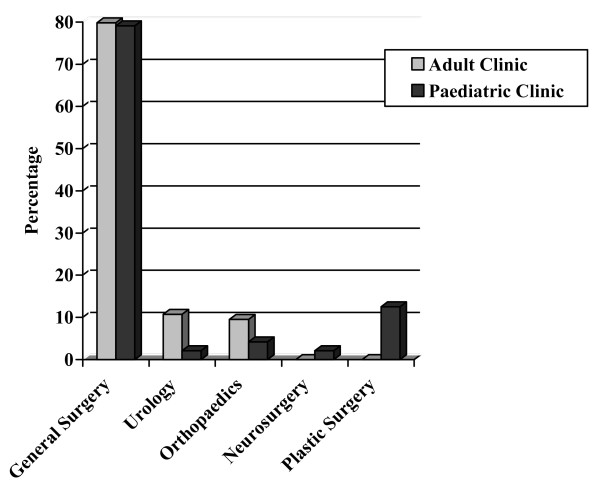
Utilization of preanaesthetic clinics by surgical specialties. (Percentage refers to the proportion of patients with respect to total attendance of the preanaesthetic clinics)